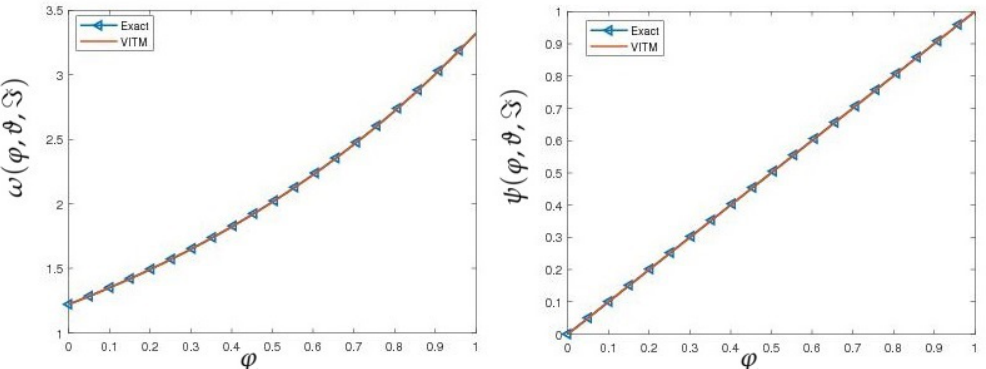
Figure 10. The exact and approximate solution graphs of ω ( ϕ , ϑ ) and ψ ( ϕ , ϑ ) , Example